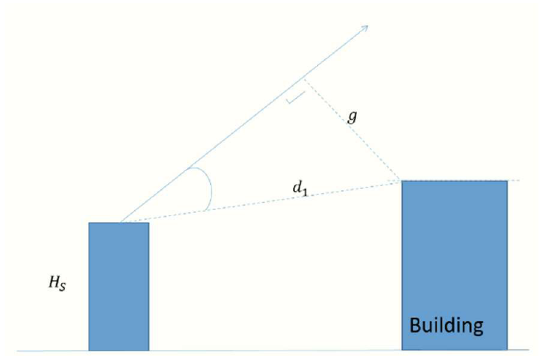
Figure 8. Geometry of the knife-edge diffraction model.